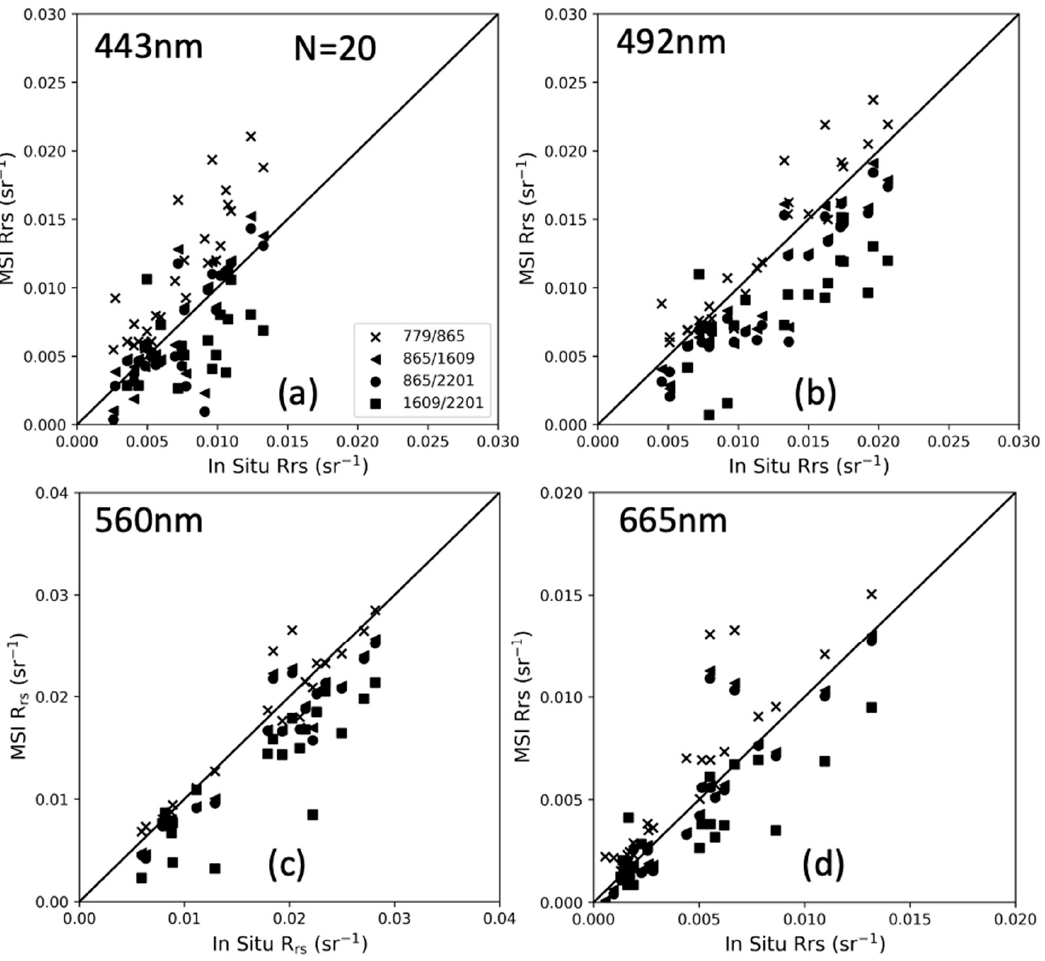
Figure 15. Validation of MSI-derived remote sensing reflectance ( R rs ) with in situ measurements at the Dong’ou and Muping sites at ( a ) 443 nm, ( b ) 492 nm, ( c ) 560 nm, and ( d ) 665 nm. The MSI Level 1C data were processed to R rs using the SeaDAS with four band combinations (779/865, 865/1609, 865/2201, and 1609/2201). Table 6. The median relative percentage difference of remote sensing reflectance ( R rs ) at 443, 492, 560, and 665 nm, and aerosol optical depth at 550 nm, τ (550), and 865 nm, τ (865), between the SeaPRISM and MSI-derived products using the ACOLITE and SeaDAS atmospheric correction software packages at the Muping and Dong’ou